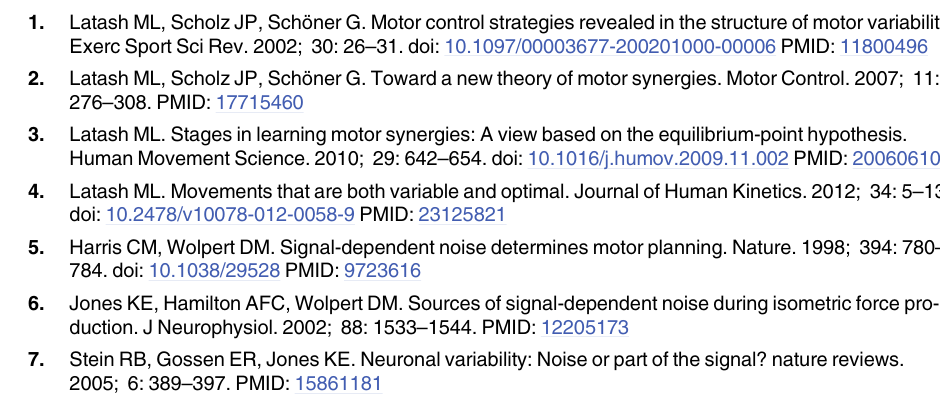
S3 Table. Specific values of the change in the tracking performance shown in Fig 8. S4 Table. Specific values of results of UCM analysis in simulation experiment shown in